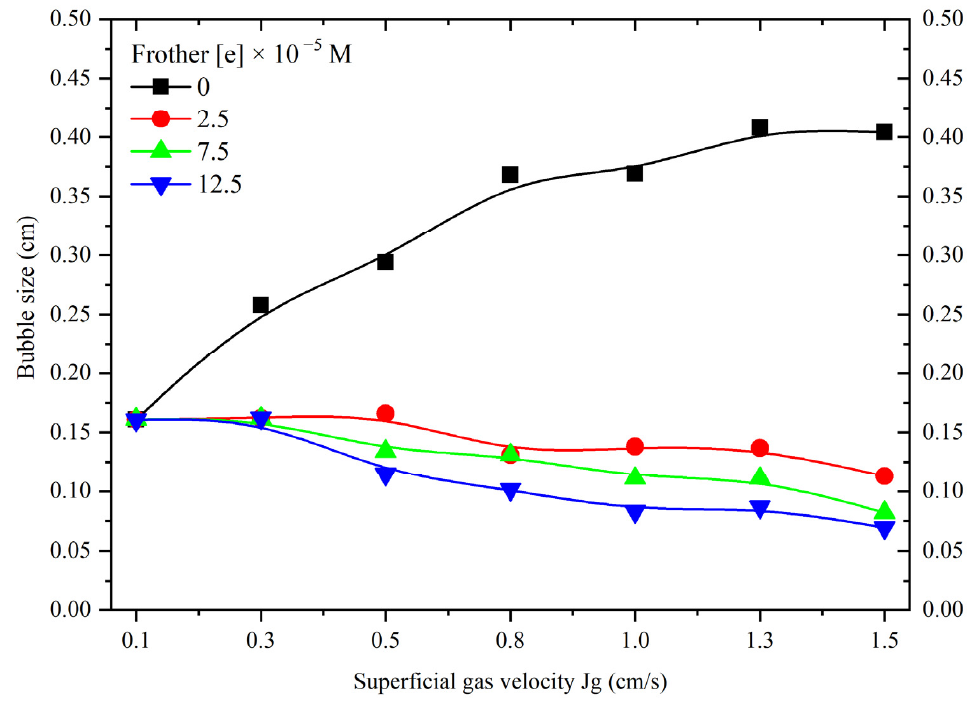
Figure 7. Bubble diameter (cm) as function of superficial gas velocity Jg (cm/s), [e] 0, 2.5 × 10 − 5 M, 7.5 × 10 − 5 M, and 12.5 × 10 − 5 M, ceramic sparger.